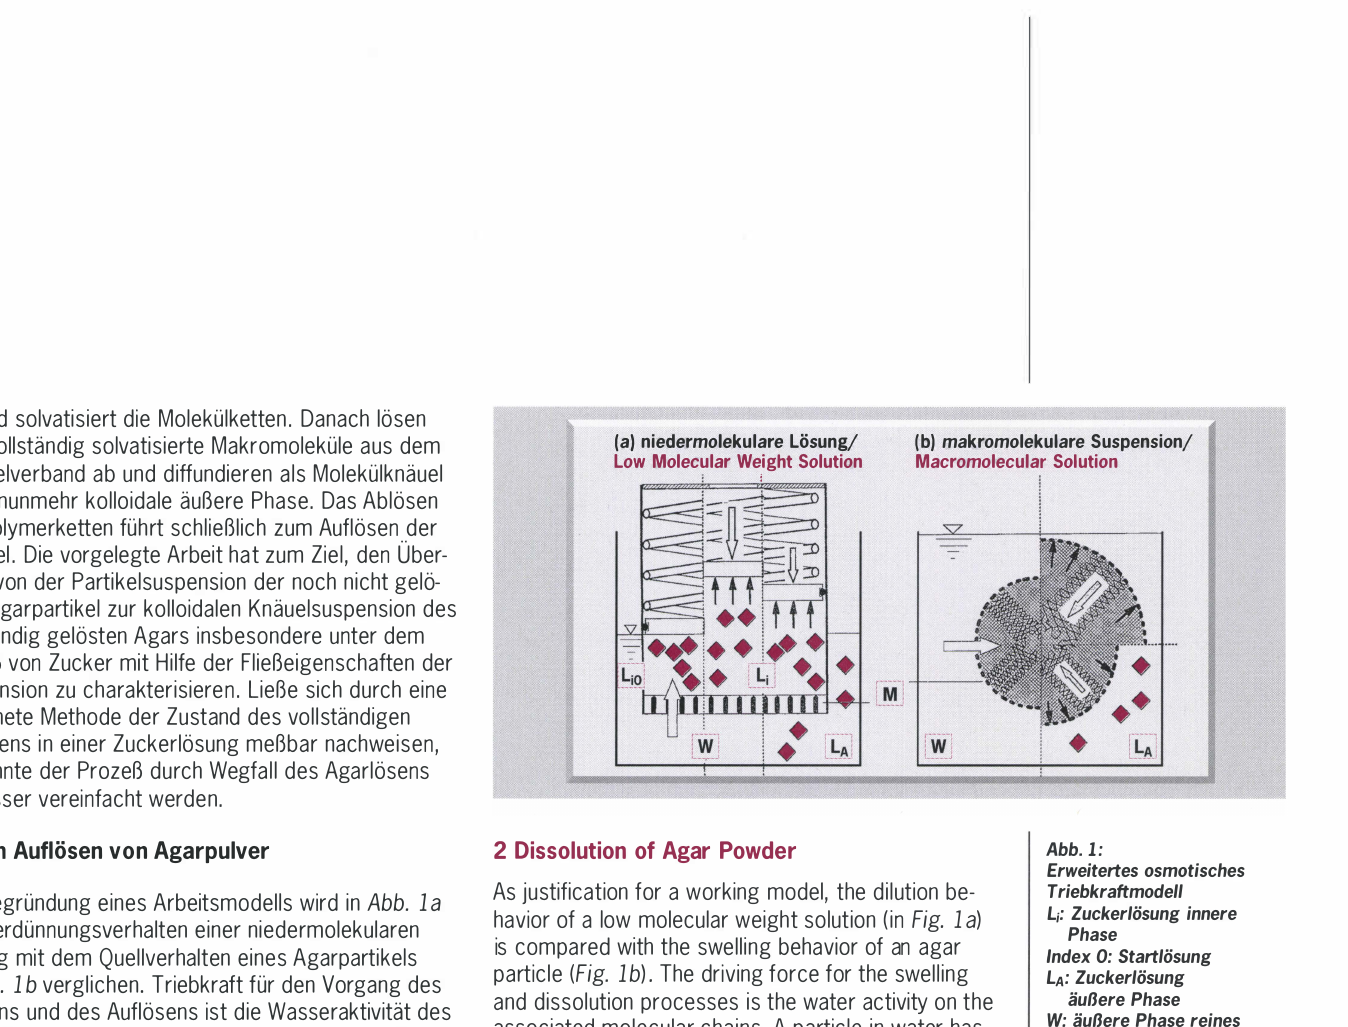
2 Dissolution of Agar Powder As justification for a working model, the dilution be­ havior of a low molecular weight solution (in Fig. 1 a) is compared with the swelling behavior of an agar particle (Fig. 1 b). The driving force for the swelling and dissolution processes is the water activity on the associated molecular chains. A particle in water has membrane M [2]. Water can penetrate the semiperme­ able membrane M into the cell, but the polymer chains dissolved in the enclosed solution cannot pass out through the membrane. Due to the osmotic potential, water flows into the cell, diluting the solution and increasing its size. The mechanical spring counteracts librium dilution. This working model is now extended: